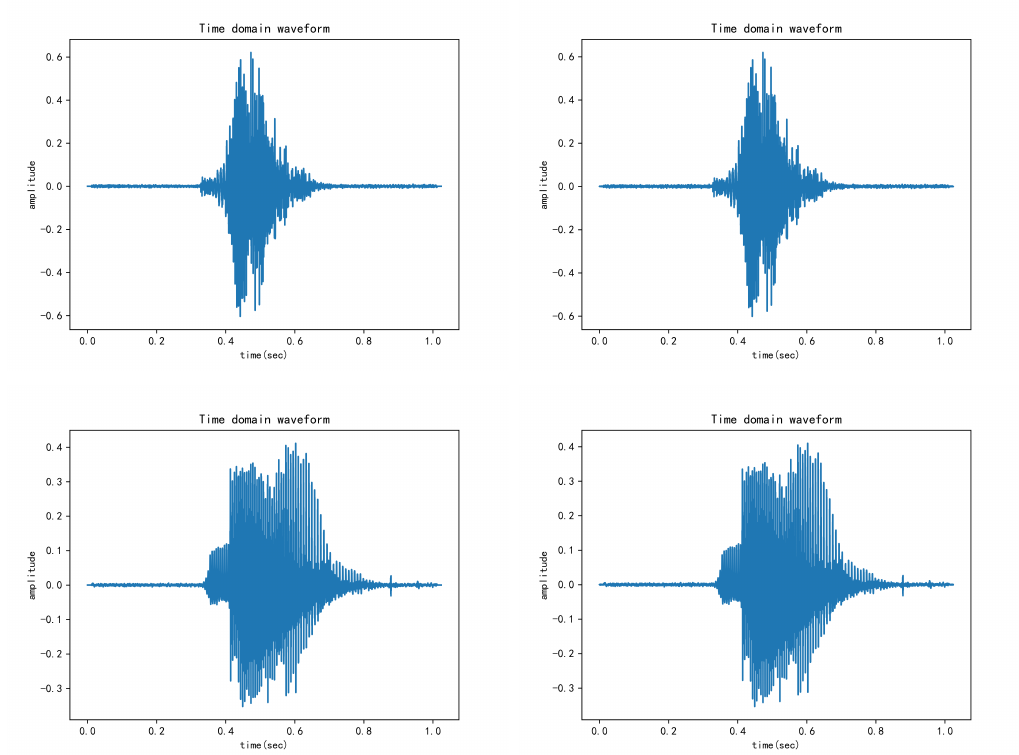
Figure 11. The time-domain waveform. The left column is the time-domain waveform of the secret audios, and the right column is the time-domain waveform of the reconstructed secret audios.